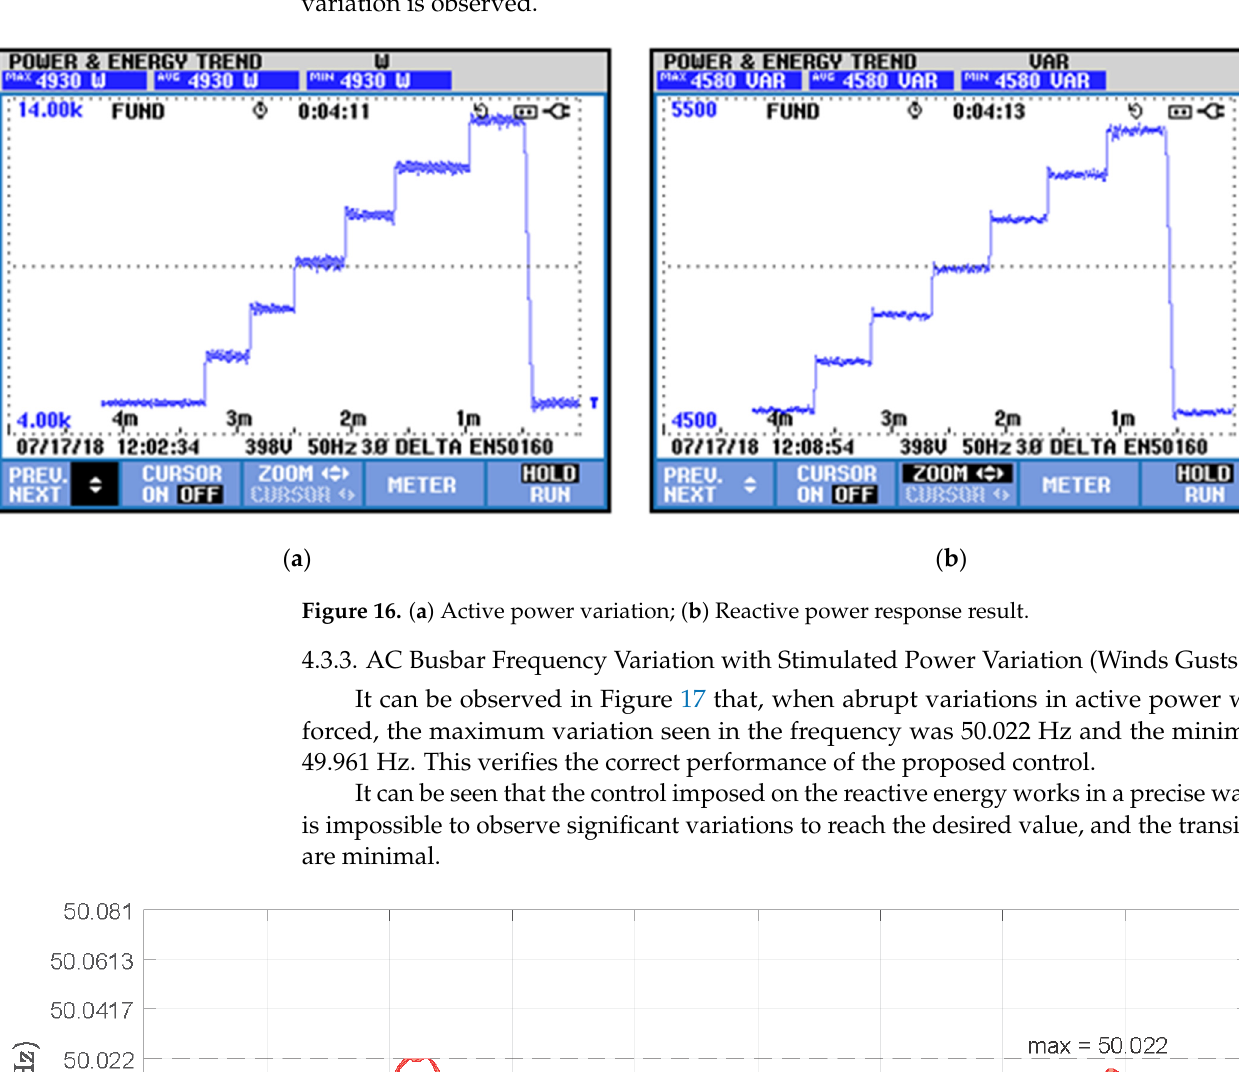
Figure 15. ( a ) Frequency Result—45, 50, and 55 Hz variation; ( b ) Reactive Power result for 45, 50, and 55 Hz frequency variation.